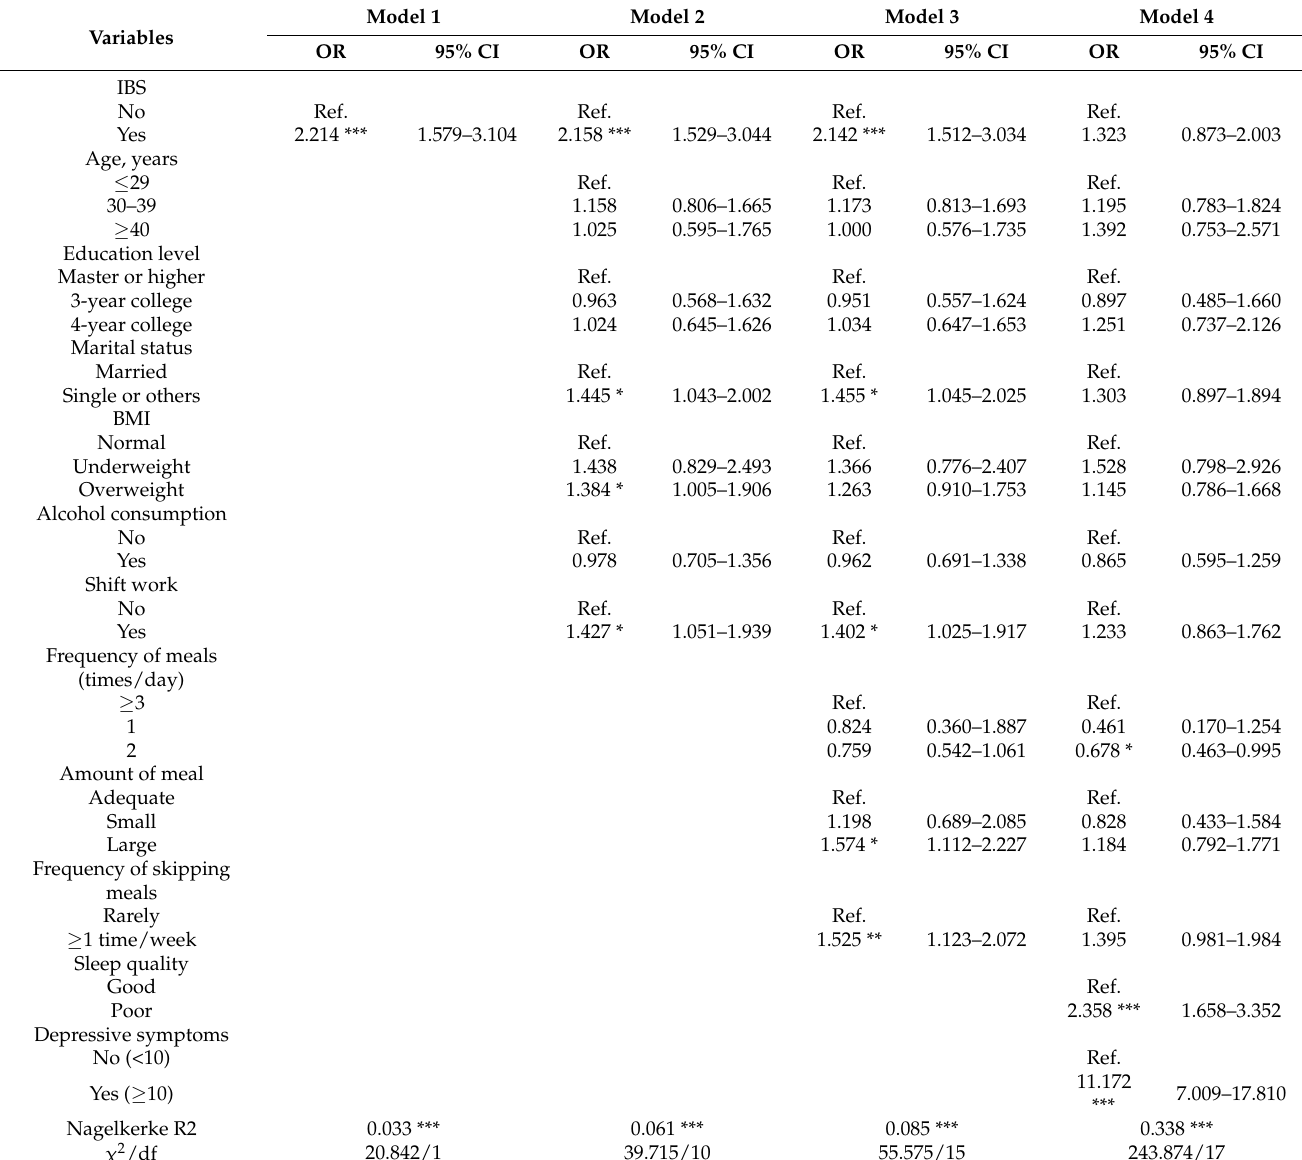
Table 3. Effect of irritable bowel syndrome on stress (N =